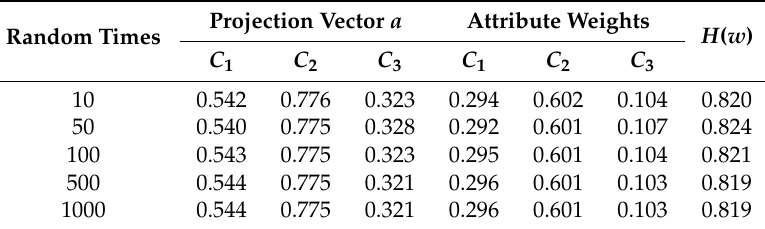
Table 5. Weights of each